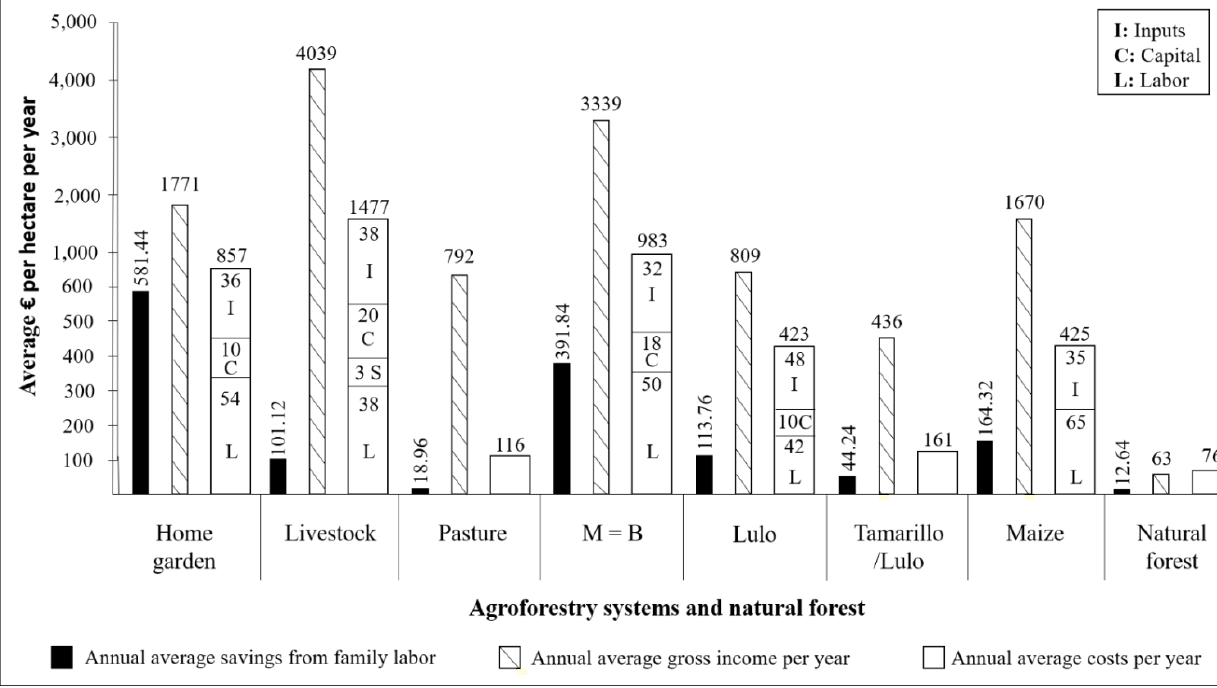
Figure 6. Annual average production costs avoided through family labor, gross income, and production costs of the agroforestry systems and natural forest.